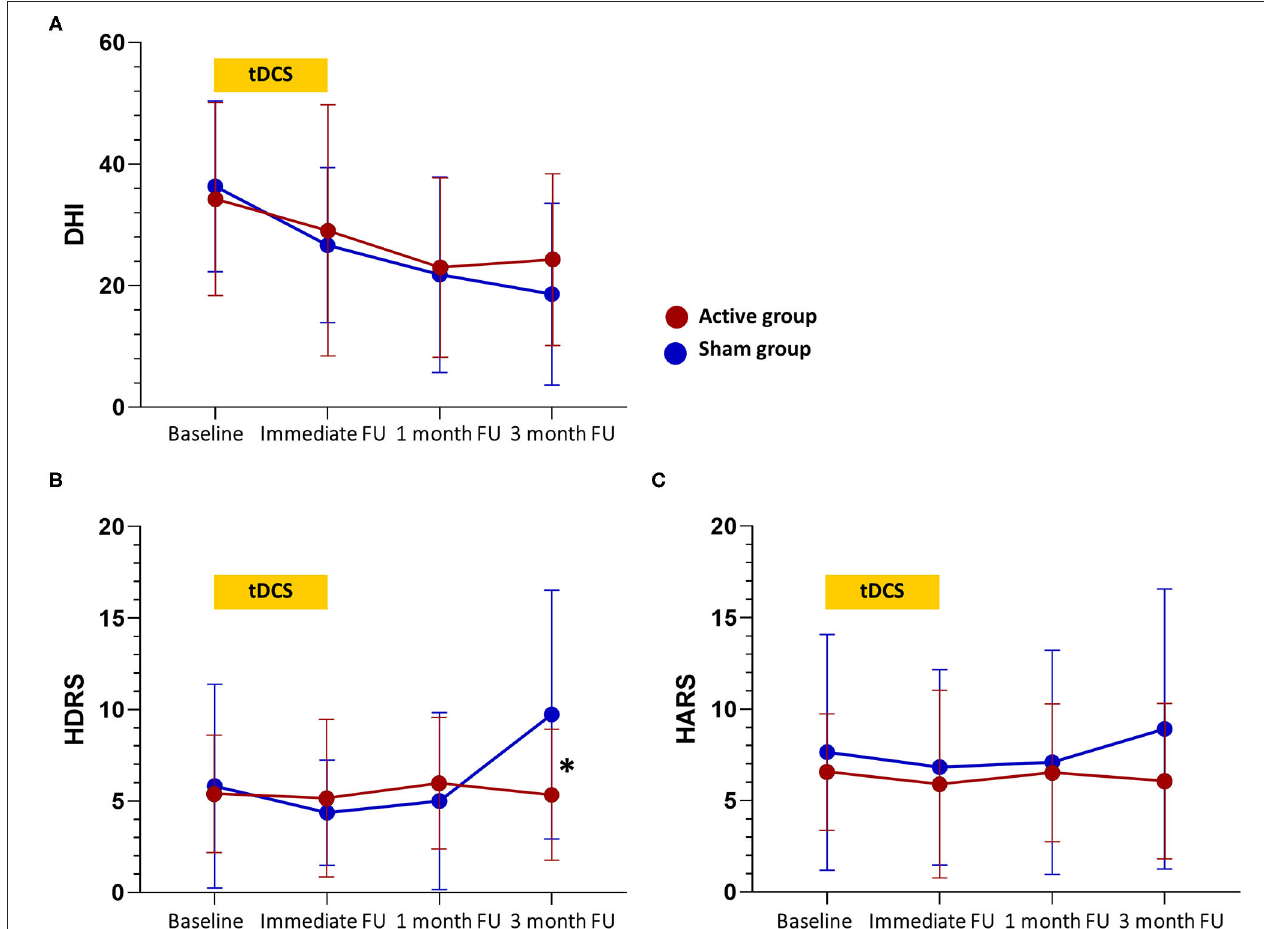
FIGURE 2 | Changes in clinical scores over time. (A) Changes in the Dizziness Handicap Inventory (DHI) total score. (B) Changes in the Hamilton Depression Rating Scale (HDRS) score. (C) Changes in the Hamilton Anxiety Rating Scale (HARS) score. tDCS sessions were between baseline and immediate follow-up. Values are mean scores and error bars indicate 95% confidence intervals. Significant differences at the p < 0.05 level between groups at a time point are denoted with a “*”. FU,